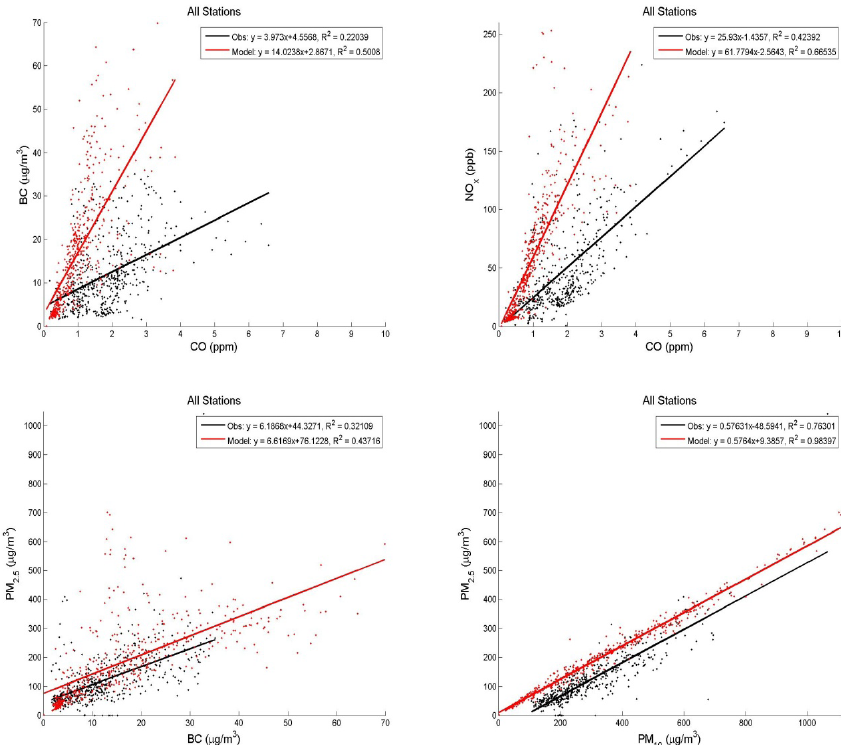
Figure 12. Comparison of correlations between different species for all the sites combined based on observations and modeled